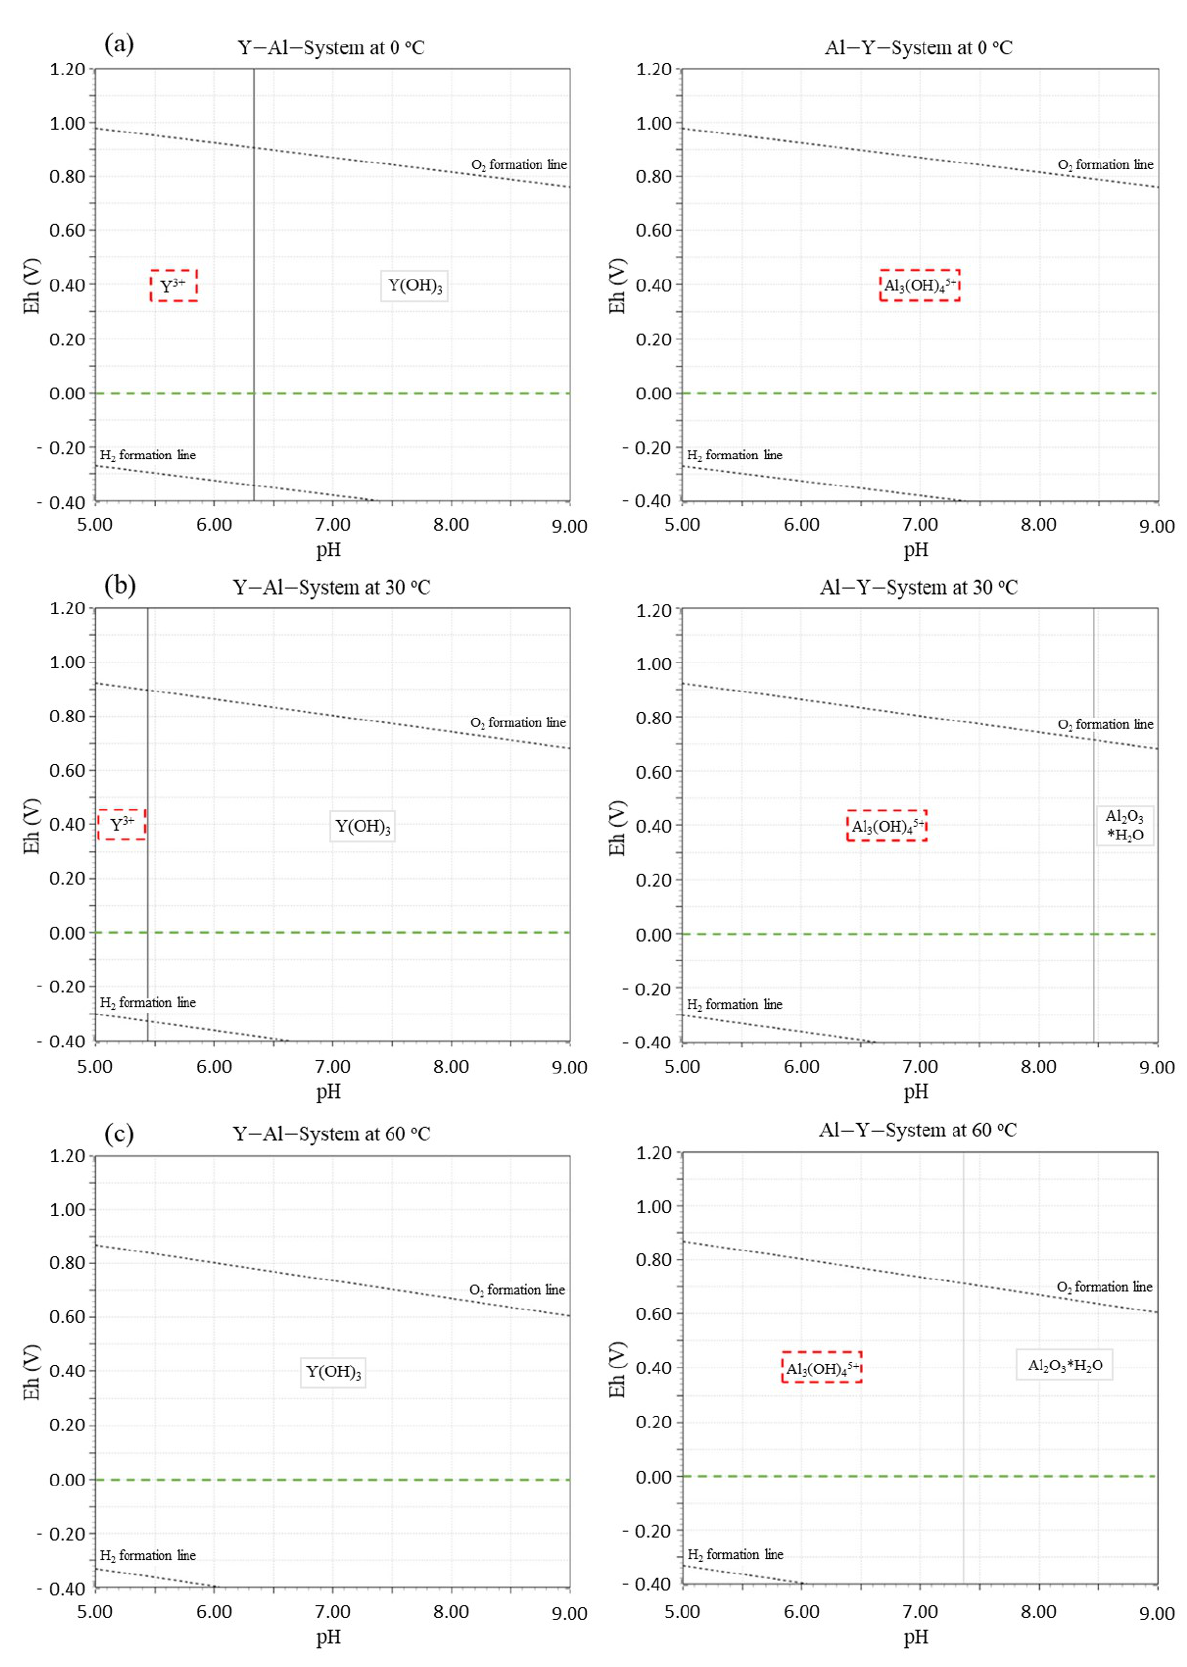
Figure 1. Eh-pH diagrams of YAlO 3 for Y ( left ) and Al ( right ) at ( a ) 0 ◦ C, ( b ) 30 ◦ C, and ( c ) 60 ◦ C in fresh